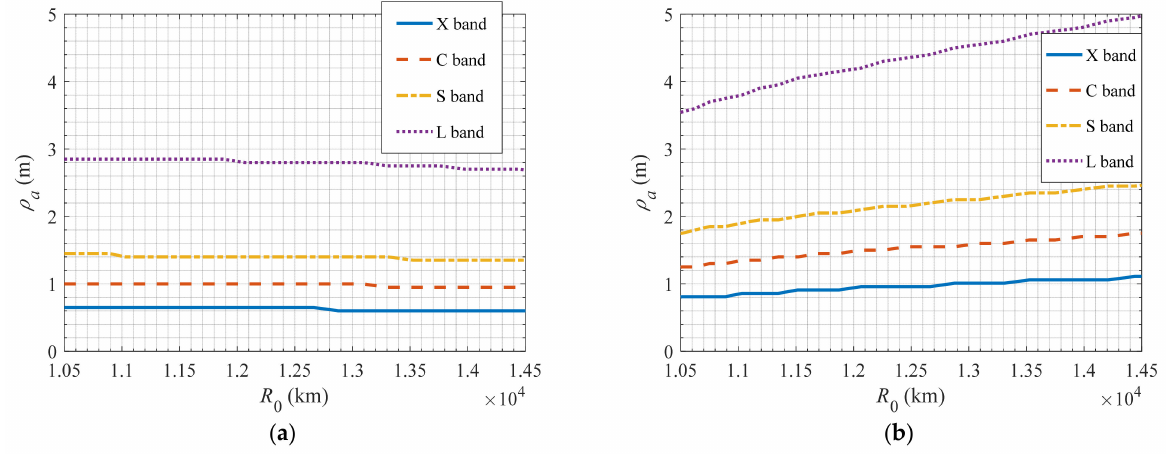
Figure 12. Lower Bounds of azimuth resolution for the cubic-approximated range equation. ( a ) Targets with constant speeds and ( b ) accelerating